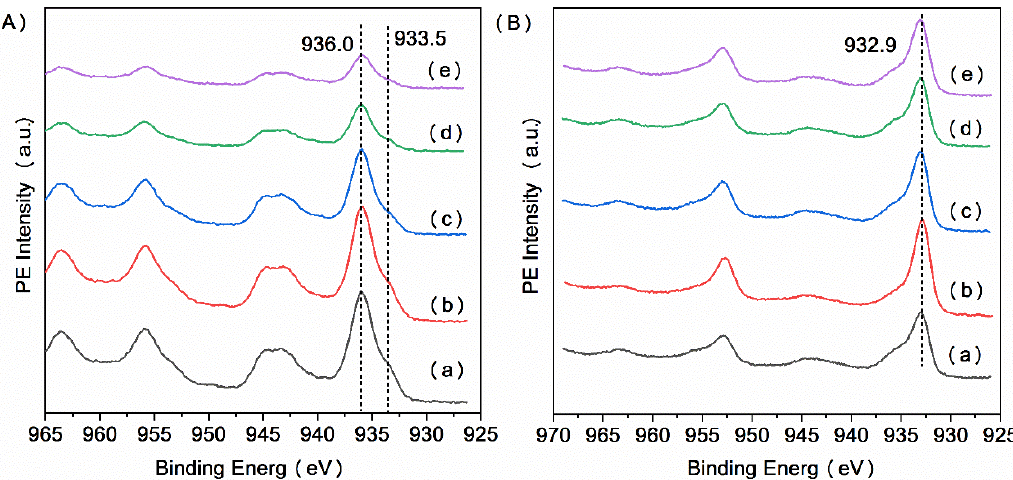
Figure 6. XPS spectra of ( A ) the calcined catalysts and ( B ) the reduced catalysts of xE-Cu/SiO 2 . (a) Cu/SiO 2 , (b) 0.04E-Cu/SiO 2 , (c) 0.08E-Cu/SiO 2 , (d) 0.12E-Cu/SiO 2 , (e) 0.3E-Cu/SiO 2 .